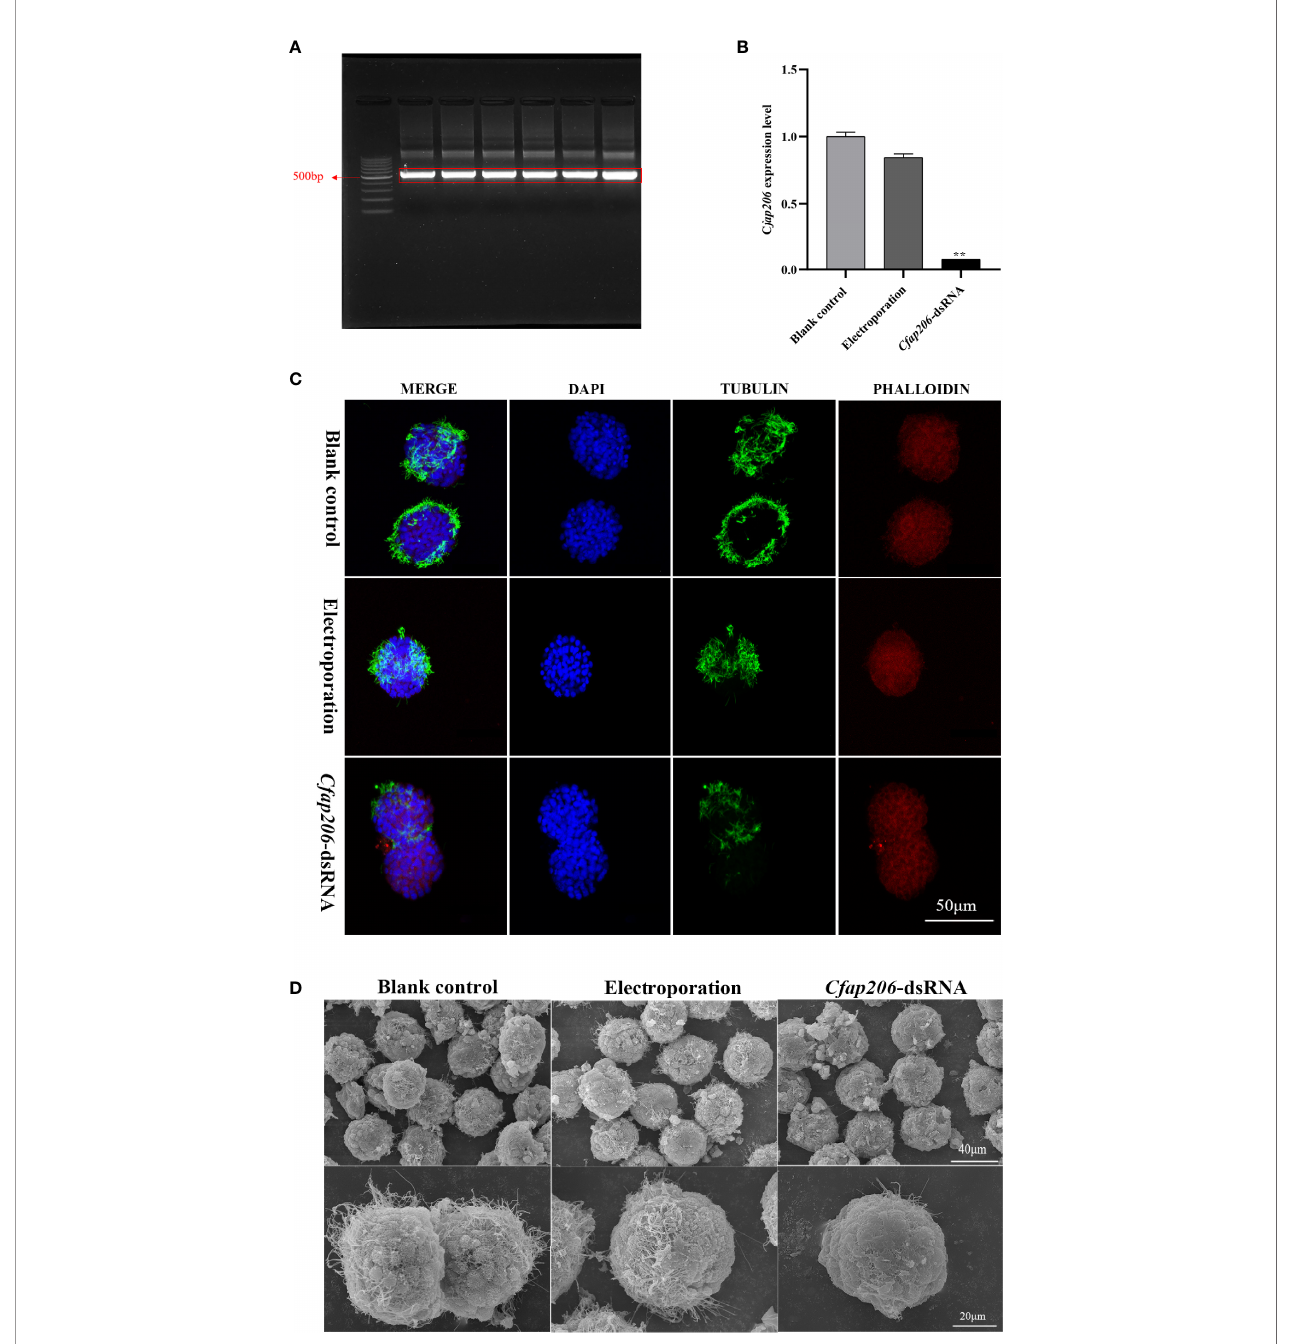
FIGURE 3 | Expression analysis of Cfap206 and morphological observation of trochophore larvae after RNAi. (A) Electrophoresis result of Cfap206 dsRNA. Lane 1, 100 bp DNA ladder. Lanes 2 – 7, bands of Cfap206 -dsRNA (500 bp). (B) The expression of Cfap206 after RNAi (detected by qPCR). ** p < 0.01. (C) Confocal observation of trochophore larvae after RNAi. Cytoskeleton was stained red by phalloidin, nucleus was stained blue by DAPI, and cilia were stained green by tubulin antibody. (D) SEM observation of trochophore larvae after